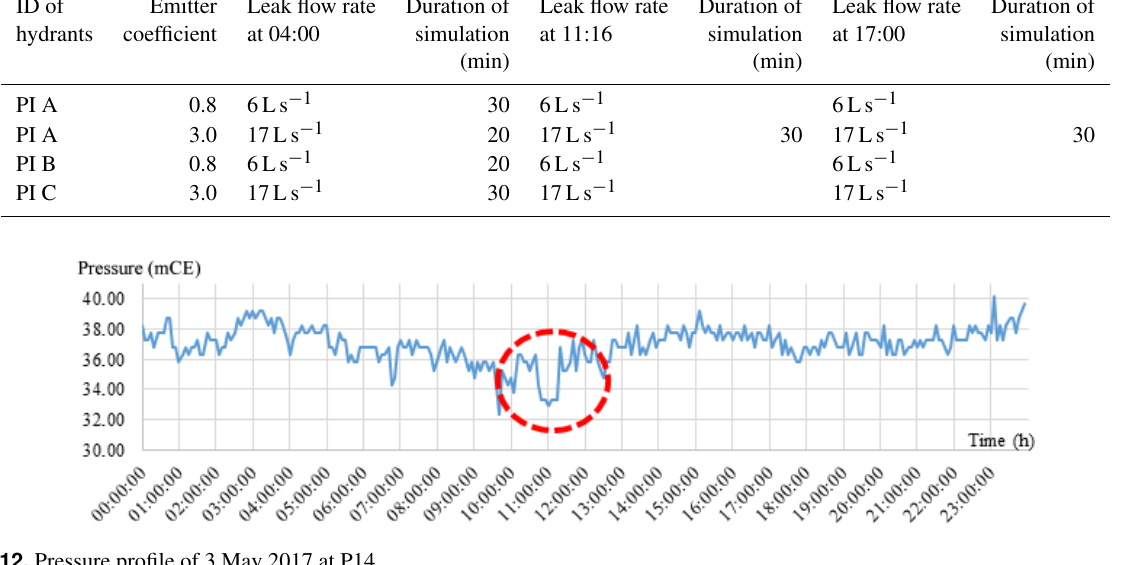
Figure 12. Pressure profile of 3 May 2017 at P14.